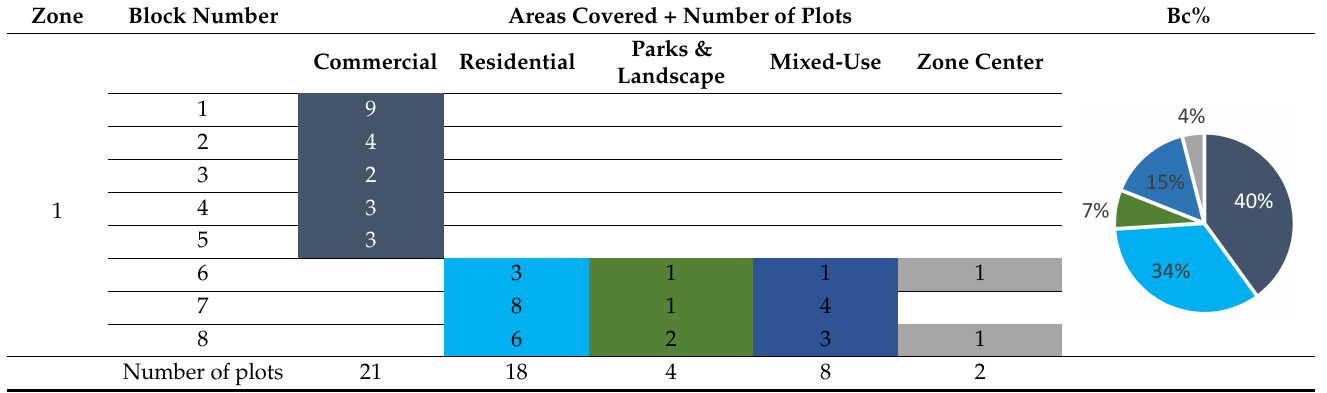
Table 3. Land use characteristics of the Al Ghanim